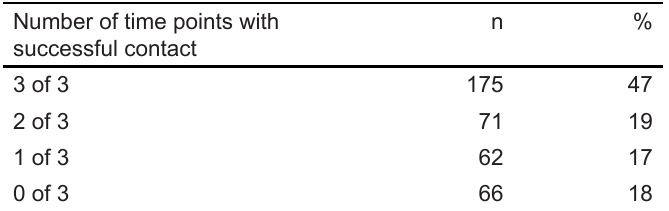
Table 3. Overall total number of successful follow-up contacts (range 0-3).